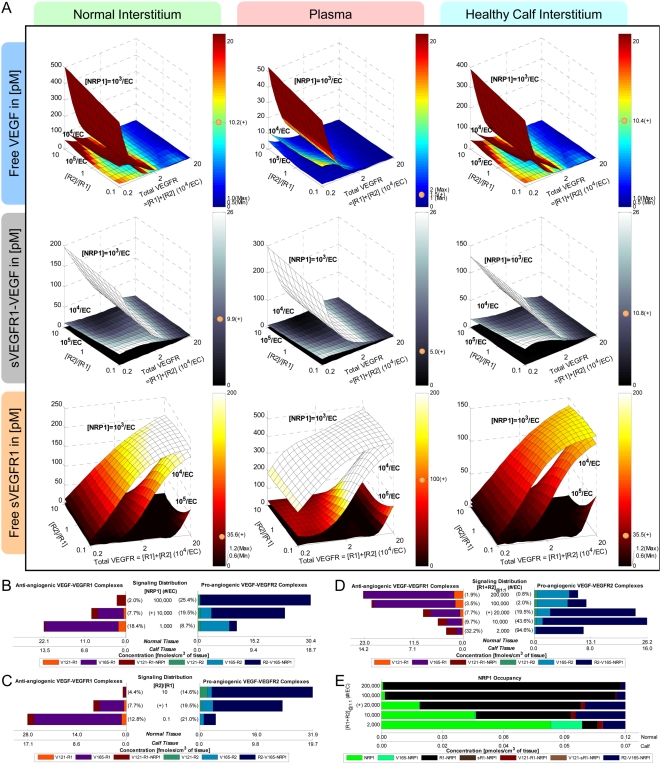
Steady-State Sensitivity to Receptor Density.A. Sensitivity of plasma and interstitial concentrations of free VEGF, free sR1, and sR1-VEGF complex to NRP1 density (3 surfaces), VEGFR1∶VEGFR2 density ratio (x-axis), and total VEGFR density (y-axis). B–D. Sensitivity of signaling complex distribution to NRP1 density (B), ratio of VEGFR2∶VEGFR1 density ratio (C), and total VEGFR density (D). Bracketed percentages are VEGF-bound fractional occupancies of total VEGFR1 (left) and total VEGFR2 (right), averaged (range <0.9%) between normal and calf compartments. E. Sensitivity of NRP1 distribution to total VEGFR density. ‘+’ = control; ‘max’ and ‘min’ bound targeted ranges; ‘EC’ = endothelial cell; ‘V121’ = VEGF121; ‘V165’ = VEGF165; ‘R1’ = VEGFR1; ‘sR1’ = sVEGFR1; ‘R2’ = VEGFR2.